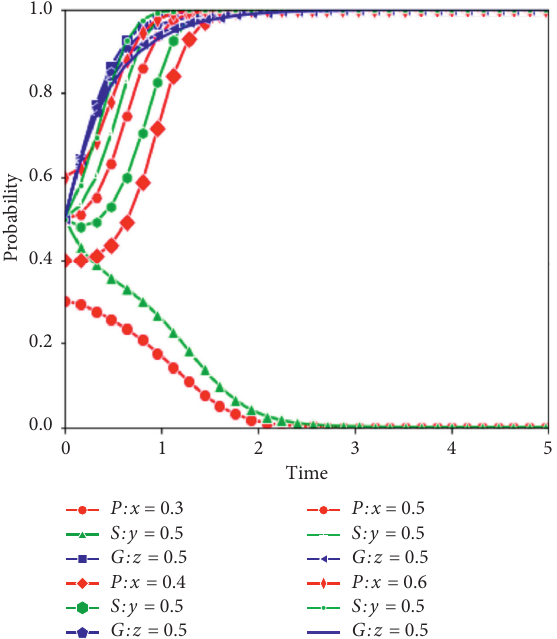
Figure 2: Dynamic evolution process of the tripartite game sub- jects when x